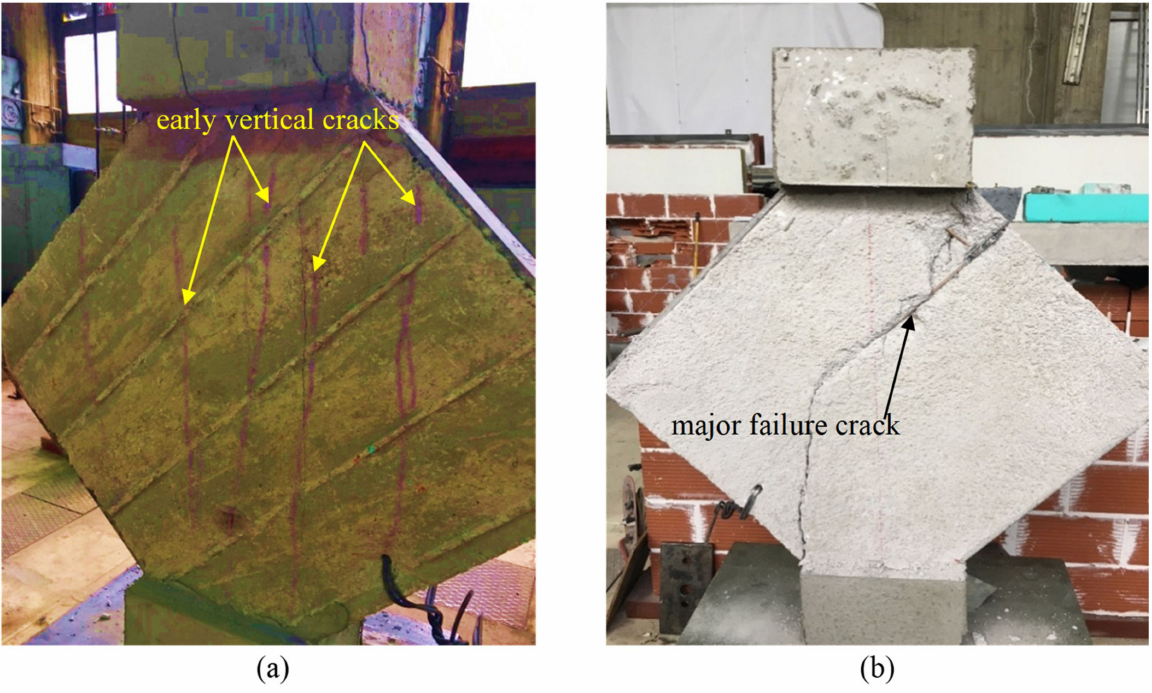
Figure 11. Failure mechanism of PCSP-3a specimen under diagonal compression: ( a ) vertical cracks on the concrete panels at early loading stages and ( b ) major failure crack on the concrete